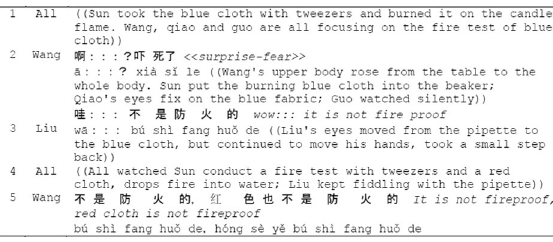
Episode 3: Blue and Red cloth are not fireproof